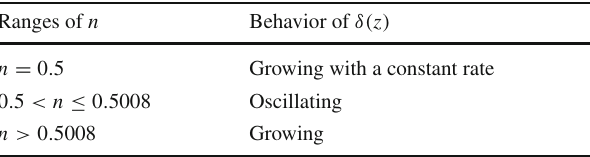
Table 1 We illustrate the features of density contrast for torsion-dust system with different ranges of n Ranges of n Behavior of δ( z ) n = 0 . 5